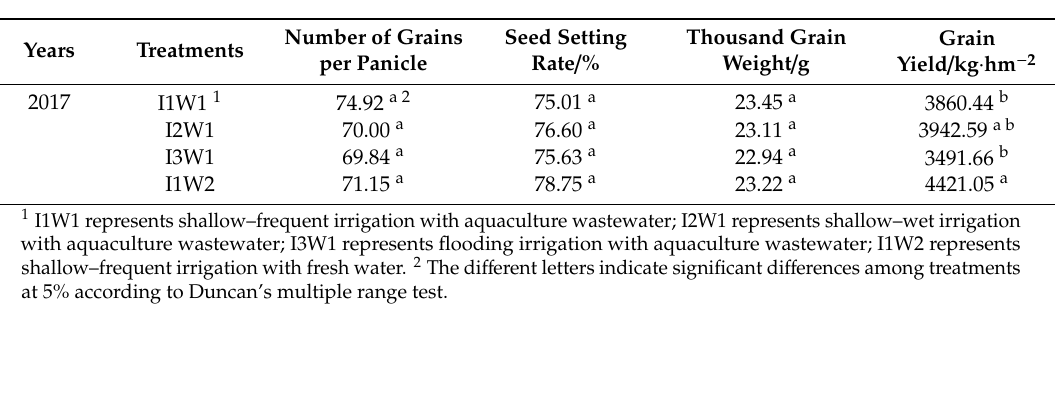
Table 3. Grain yields in di ff erent irrigation